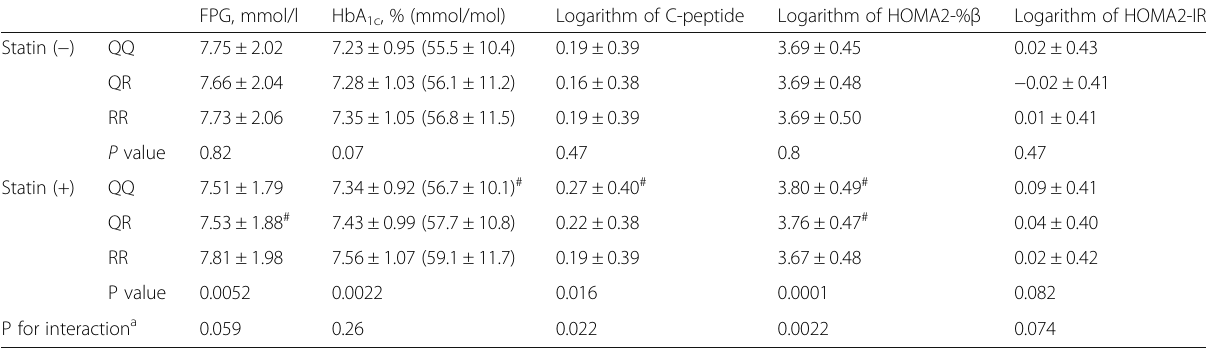
Table 2 Association of PON1 Q192R polymorphism with glycemia, insulin secretion, and sensitivity after stratified analysis by statin therapy FPG, mmol/l HbA 1c , % (mmol/mol) Logarithm of C-peptide Logarithm of HOMA2-% β Logarithm of